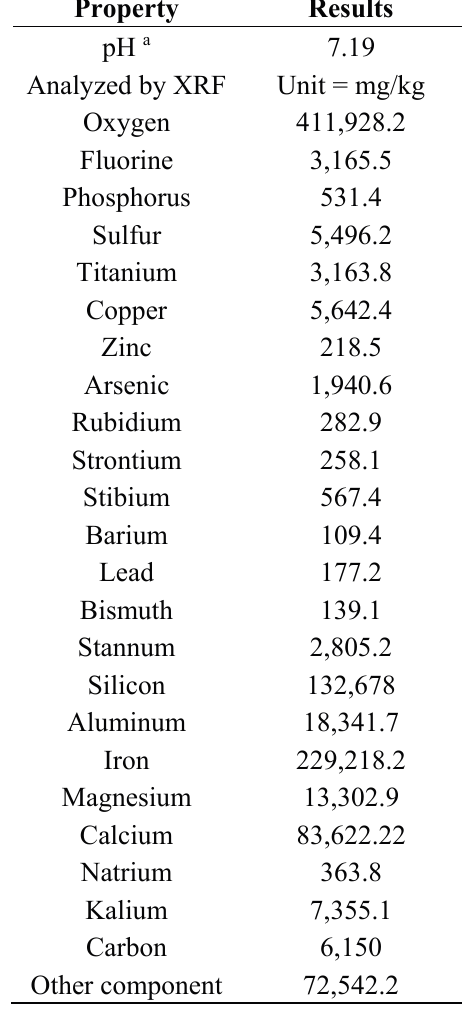
Table 3. Chemical properties of the iron